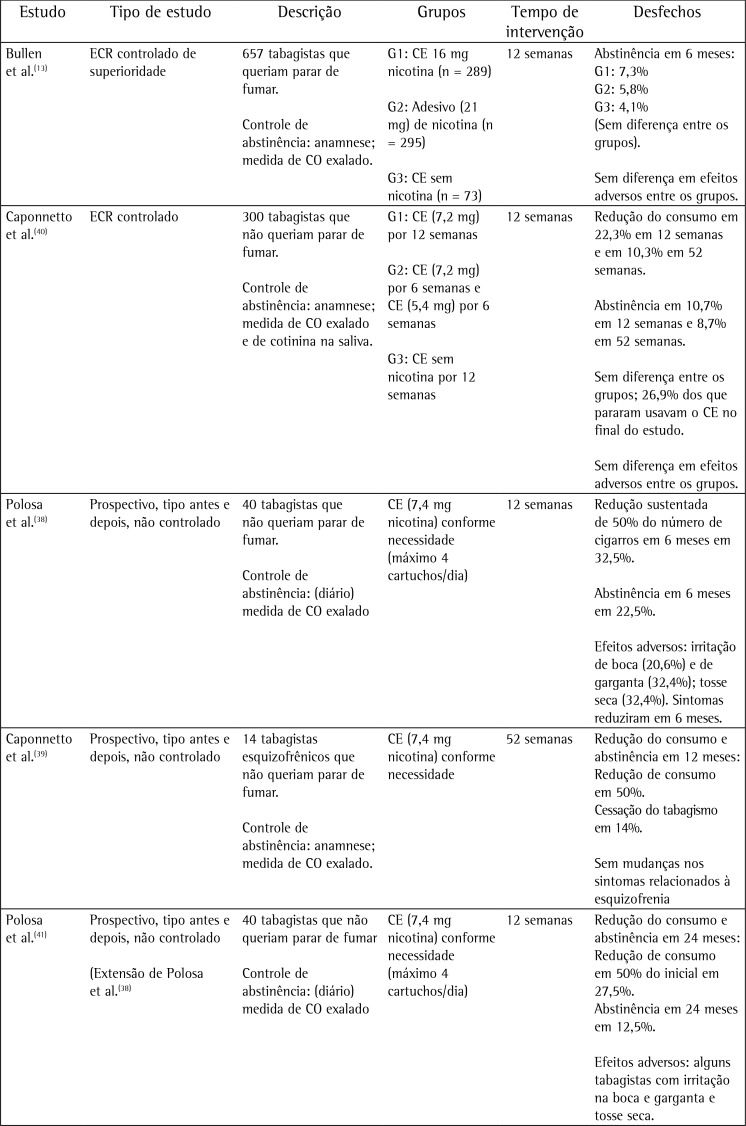
Estudos clínicos que avaliaram os efeitos do cigarro eletrônico na
redução e na cessação do tabagismo ECR: ensaio clínico randomizado; CO:
monóxido de carbono; CE: cigarro eletrônico; e G1, G2 e G3: grupos 1, 2 e
3.